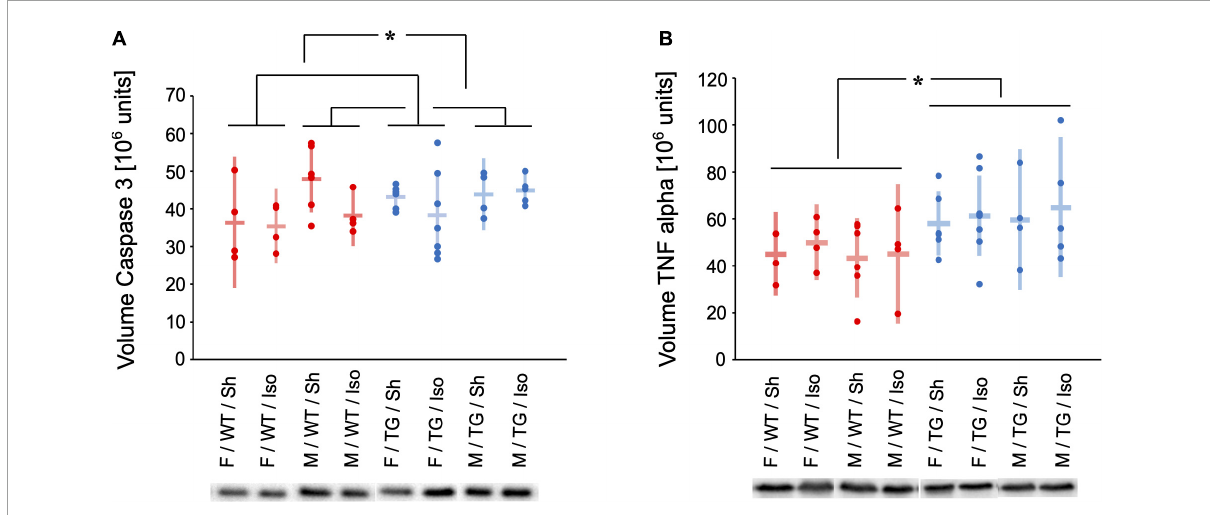
FIGURE5 Volume of Caspase 3 (A) and Tumor necrosis factor (TNF) alpha (B) [10 6 units] in the hippocampus and representative western-blot bands. Mean and 95%-confidence interval sorted by group. Caspase 3 was increased in male compared to female mice. TNF alpha was increased in Tg2576 compared to WT. F, female; M, male; WT, wildtype (red); TG, Tg2576 (blue); Sh, sham procedure; Iso, isoflurane anesthesia. * p <